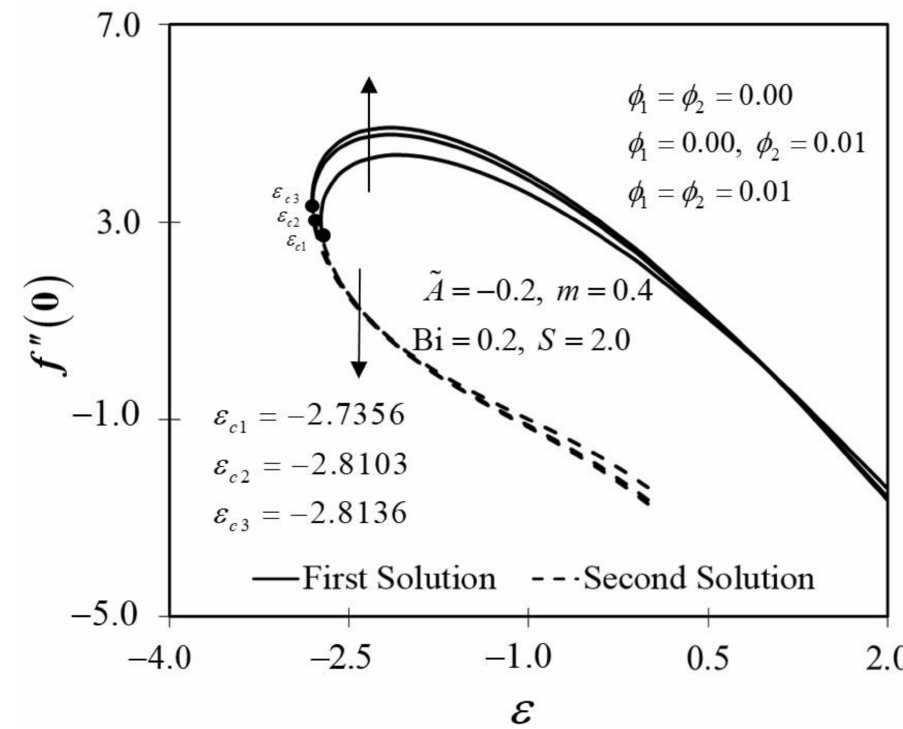
Figure 2. Trend of f (cid:48)(cid:48) ( 0 ) with ε and assorted φ .